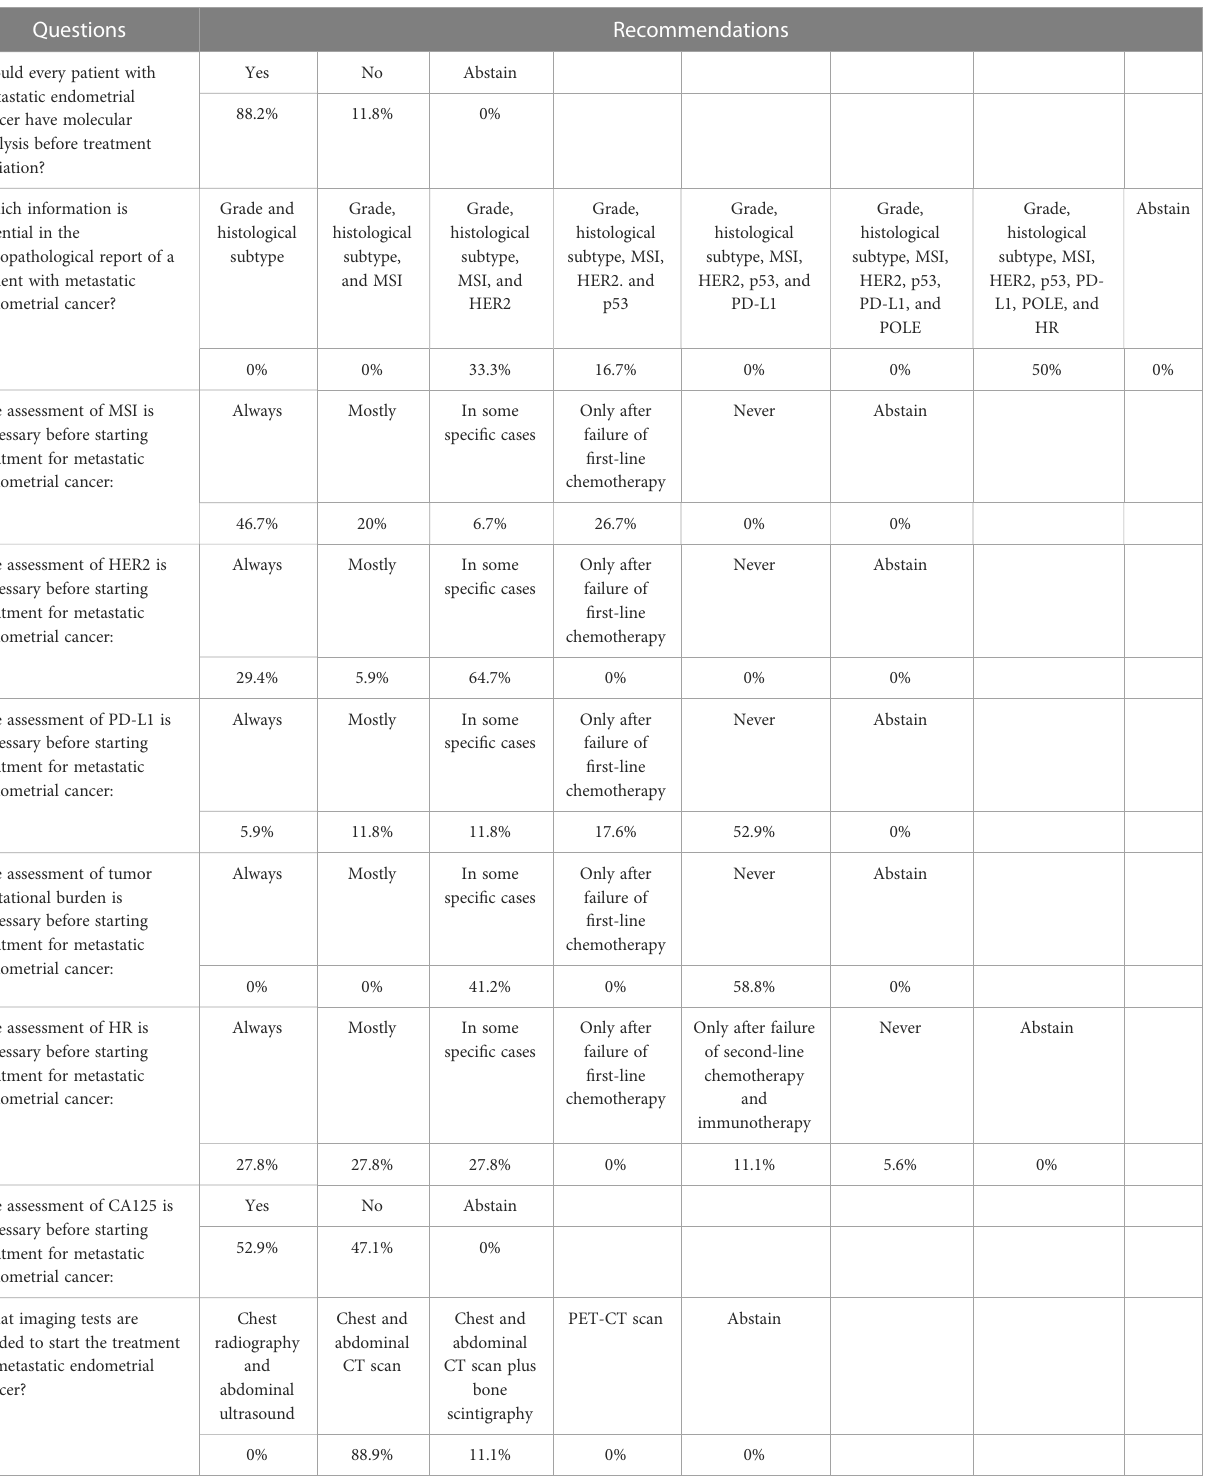
TABLE 1 Questions related to patient assessment before treatment initiation.